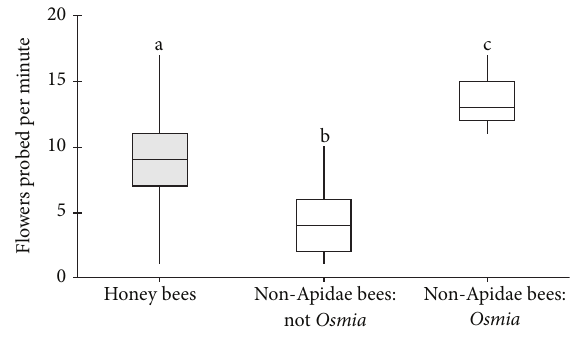
Figure 4: Osmia spp. visit significantly more flowers (13.4/minute) than other non- Osmia solitary bees (4.3/minute) and honey bees (9.2/minute). Letters display post hoc results, where groups that sharelettersdonotsignificantlydiffer.Boxlinesreportmedians,and whiskers extend either to maximum or minimum data points or to their 1.5 times the interquartile